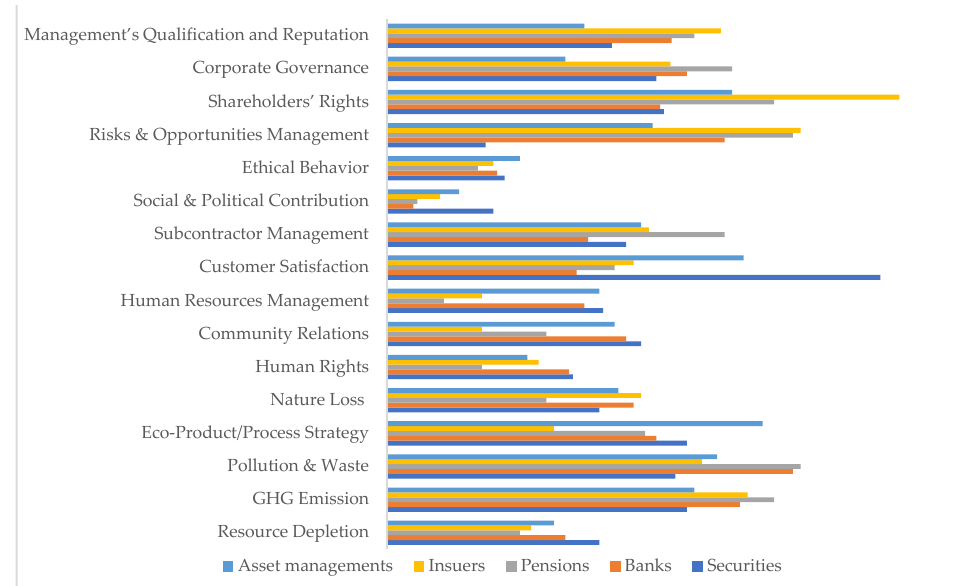
Figure 8. Global weights by investment institution.